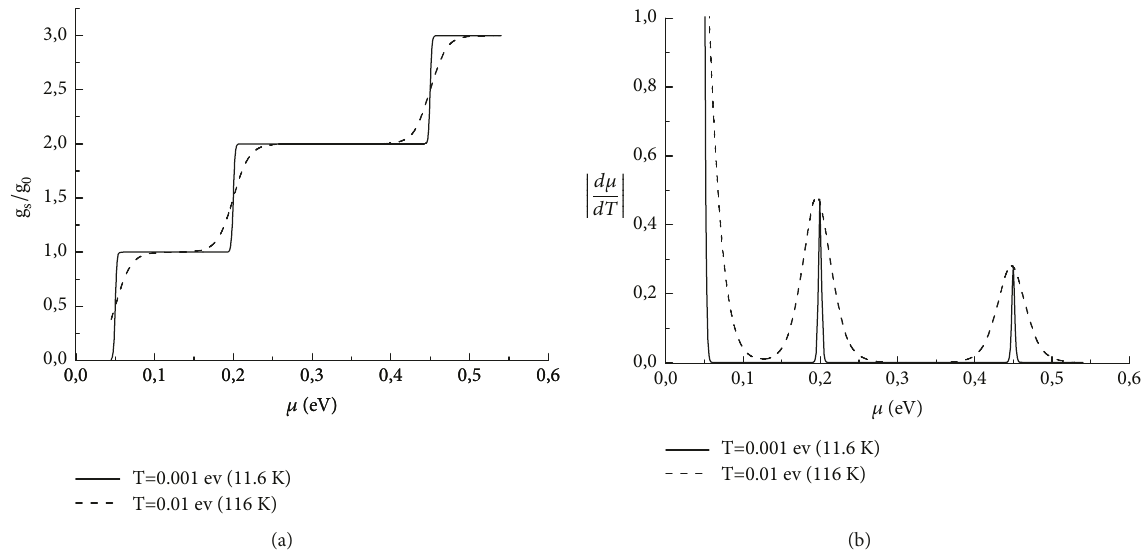
Figure 1: Dependences (a) of the density of states 𝑔 𝑠 (𝜇)/𝑔 0 and (b) a derivative of the chemical potential |𝑑𝜇/𝑑𝑇| at 𝐸 1 = 0.05 eV different temperatures: T = 0.001 eV (11.6 K), solid lines, and T = 0.01 eV (116 K), dashed